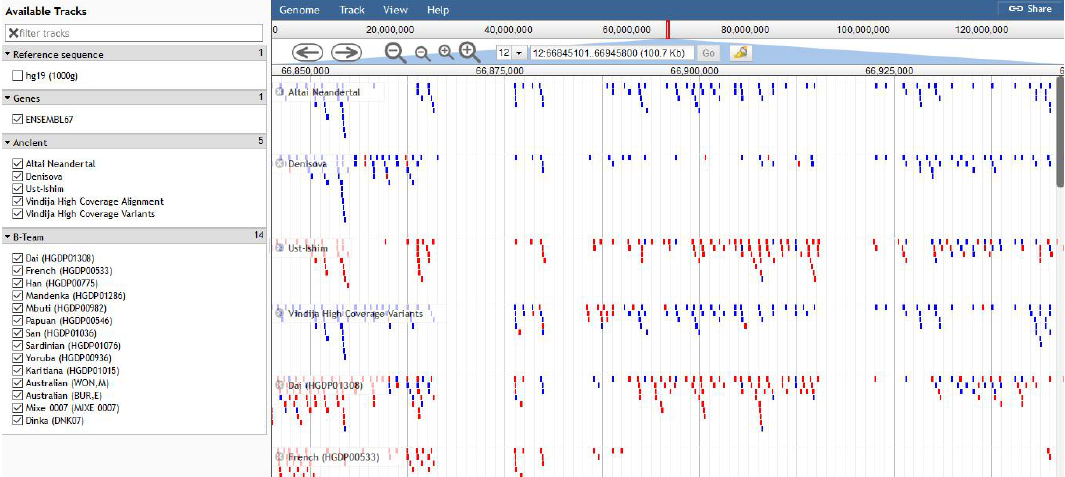
Fig. 3. Conservation of AK082072 gene: The single copy and conservation of AK082072 gene across Neanderthal genomes using Neanderthal genomes database (https://bioinf.eva.mpg.de/jbrowse/). Blue and red dots refer to homozygous and heterozygous variants,